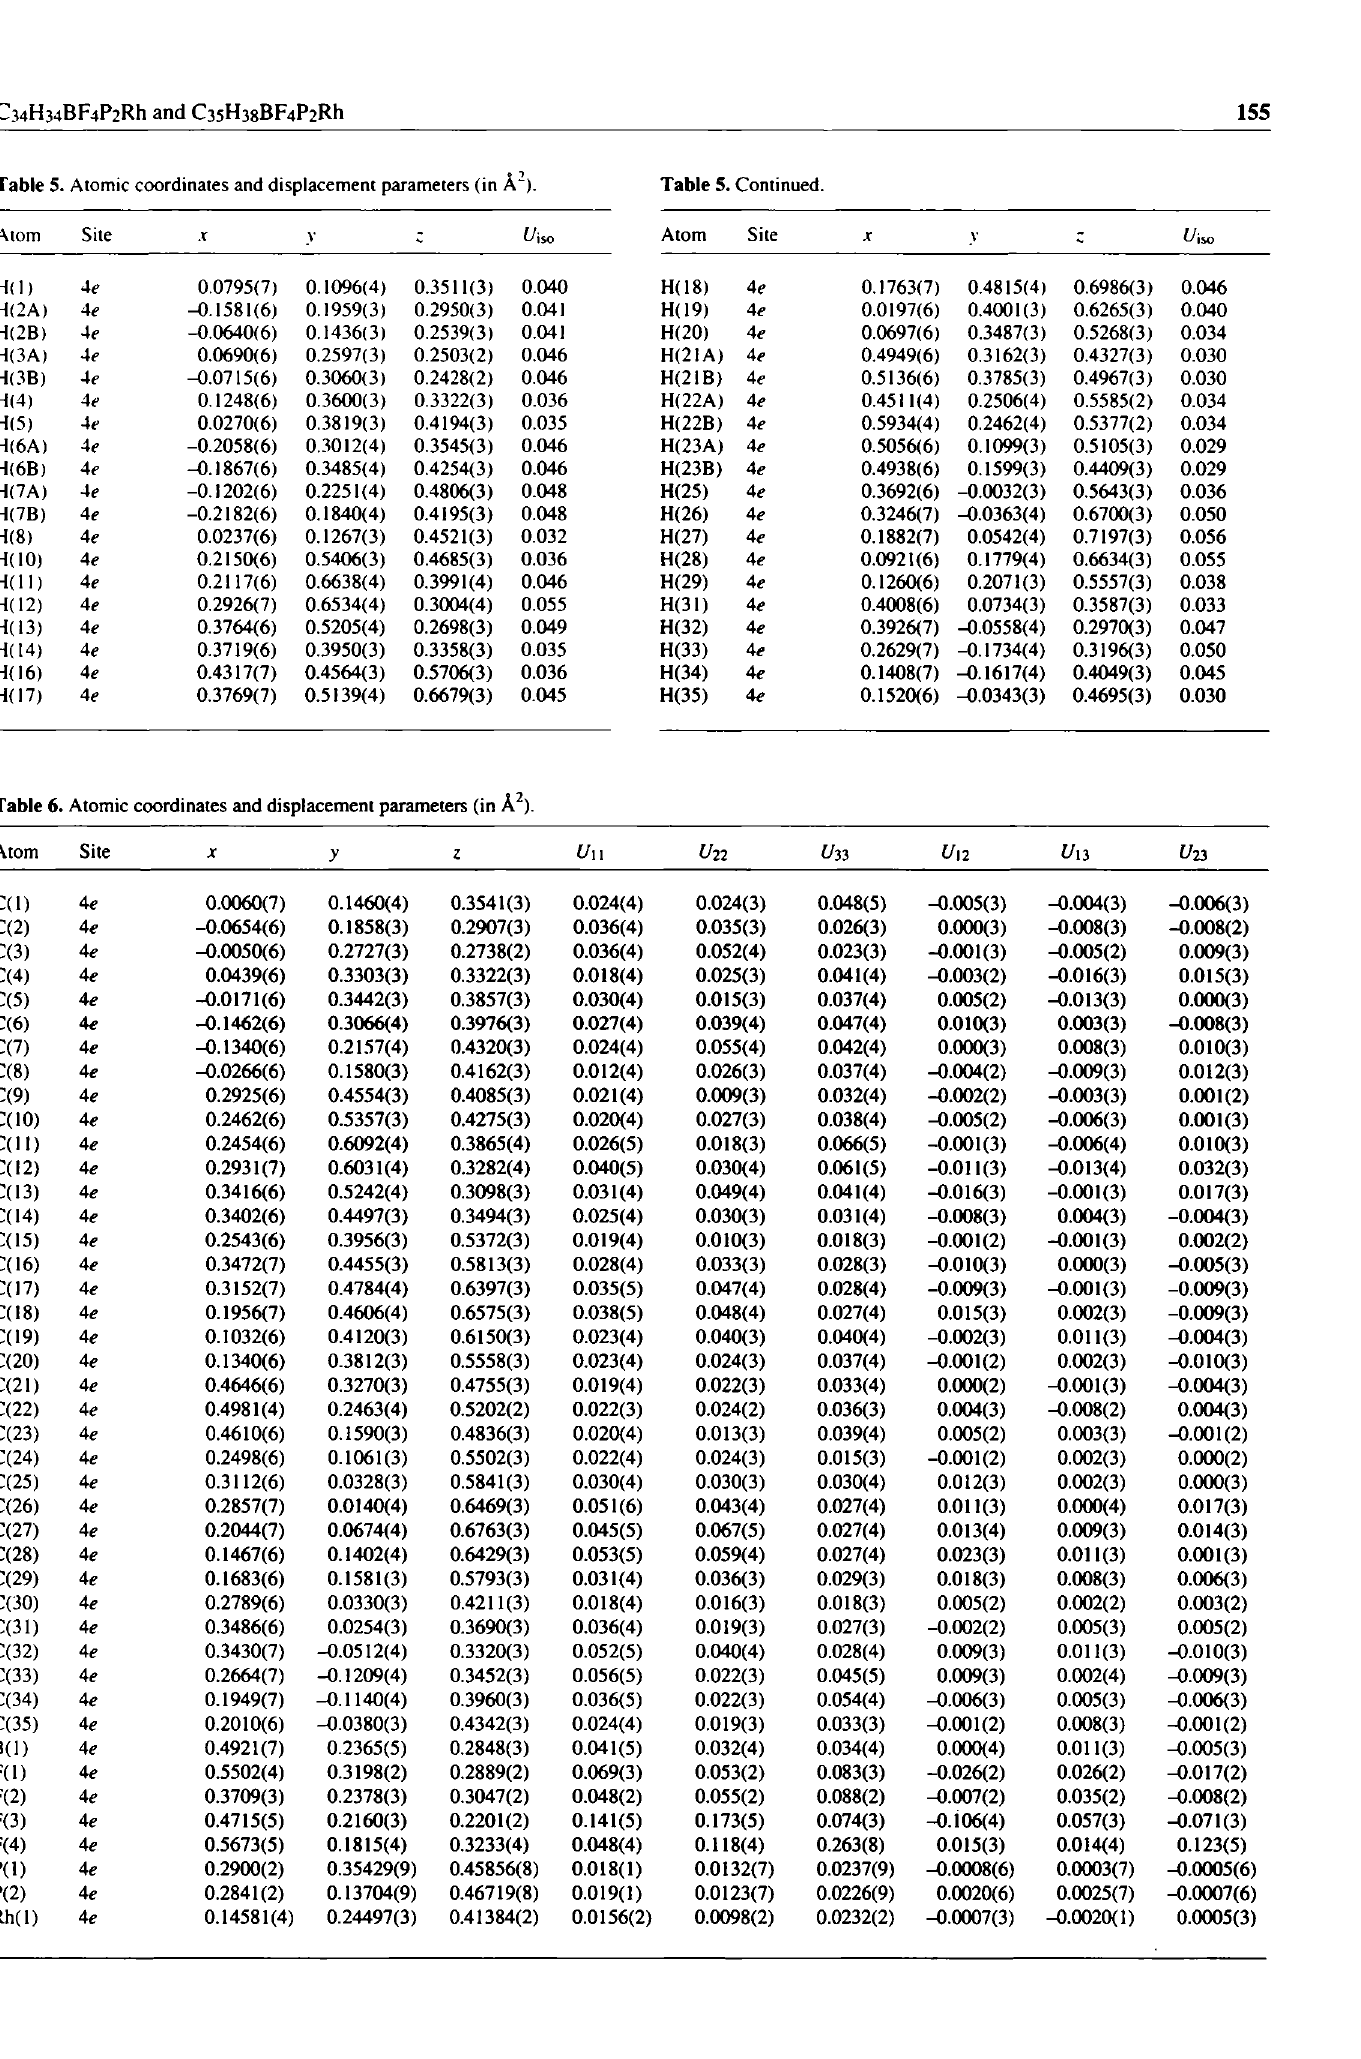
Table 6. Atomic coordinates and displacement parameters (in A 2